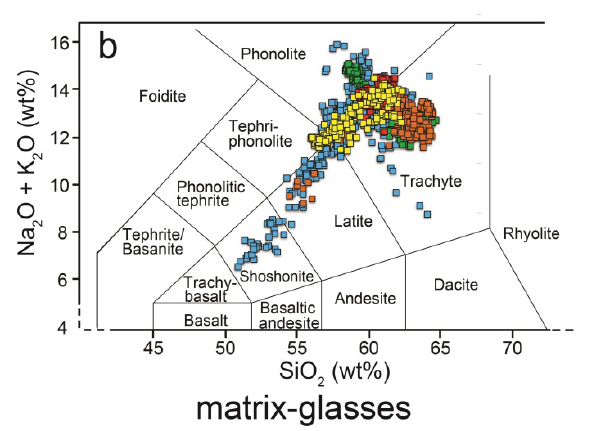
Figure 2. TAS (Total alkali vs. silica) diagram for the classification of the Campi Flegrei ( a ) whole rocks, melt inclusions and ( b ) matrix-glasses. Whole-rock, melt-inclusion and matrix-glass analysis of rocks that were erupted in different periods of Campi Flegrei’s volcanic activity are plotted. Data from Melluso et al. [51], Orsi et al. [83], Civetta et al. [52], de Vita et al. [98], Signorelli et al. [112], Pappalardo et al. [72,113], Webster et al. [114], Fulignati et al. [53], Munno and Petrosino [115], D’Oriano et al. [116], Marianelli et al. [117], Piochi et al. [95], Cannatelli et al. [87], Fowler et al. [118], Fedele et al. [69,119], Mangiacapra et al. [88], Arienzo et al. [94,101,120], Formentraux et al. [121], Tomlinson et al.[122], Belkin et al. [65], Forni et al. [55,56,89] and Iovine et al. [57]. Whole-rock analyses of the old ignimbrites are affected by alteration.